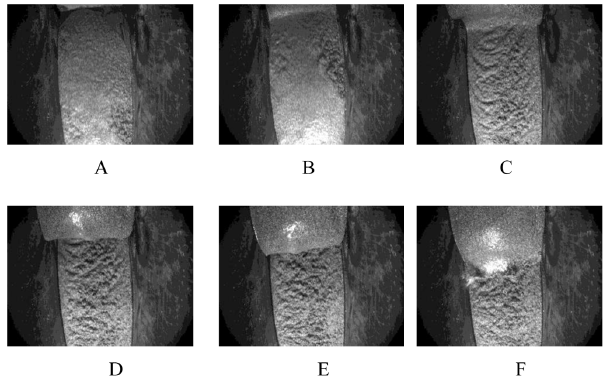
Fig. A1. Impact sequence, taken from Camera 1, for the rigid bar- rier vertically mounted (See Fig. 6). (A) debris flows at the onset of impact, (B) initial phase of the impact, (C) development of the ver- tical jet-like wave, (D) initial falling of the jet-like wave, (E) impact of the falling jet-like wave on the debris flow, (F) jet-like wave is completely fallen inside the channel.